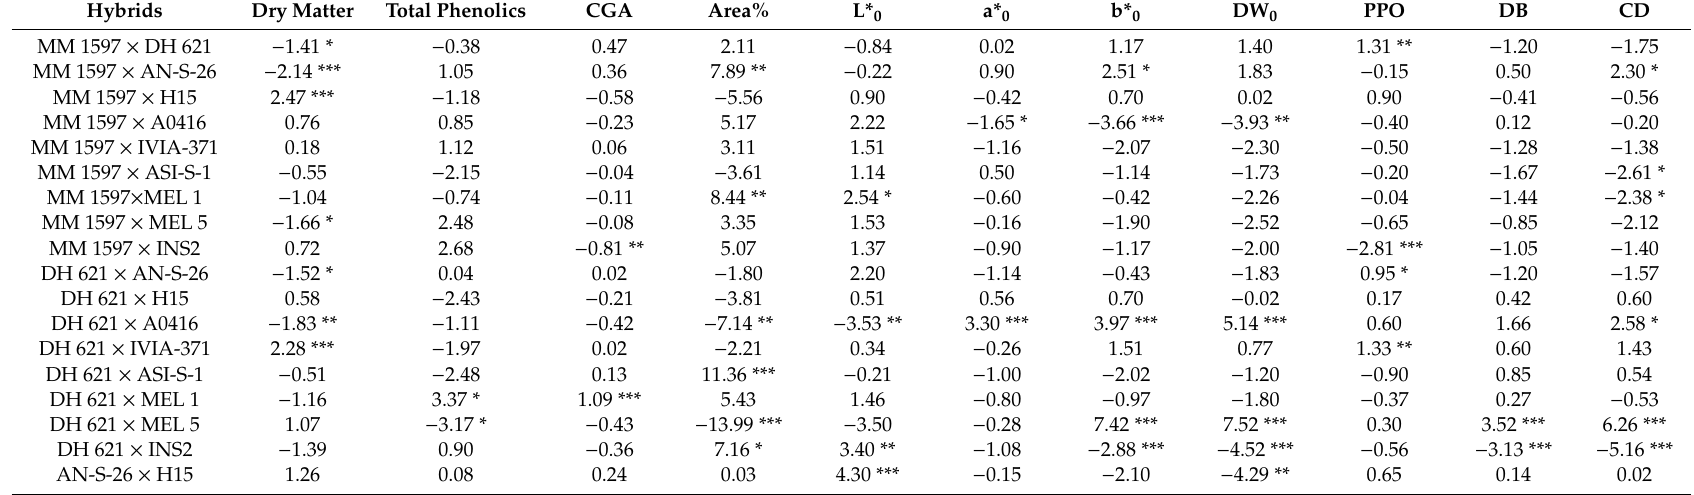
Table 4. Specific combining ability (SCA) estimates of the hybrids ( n =